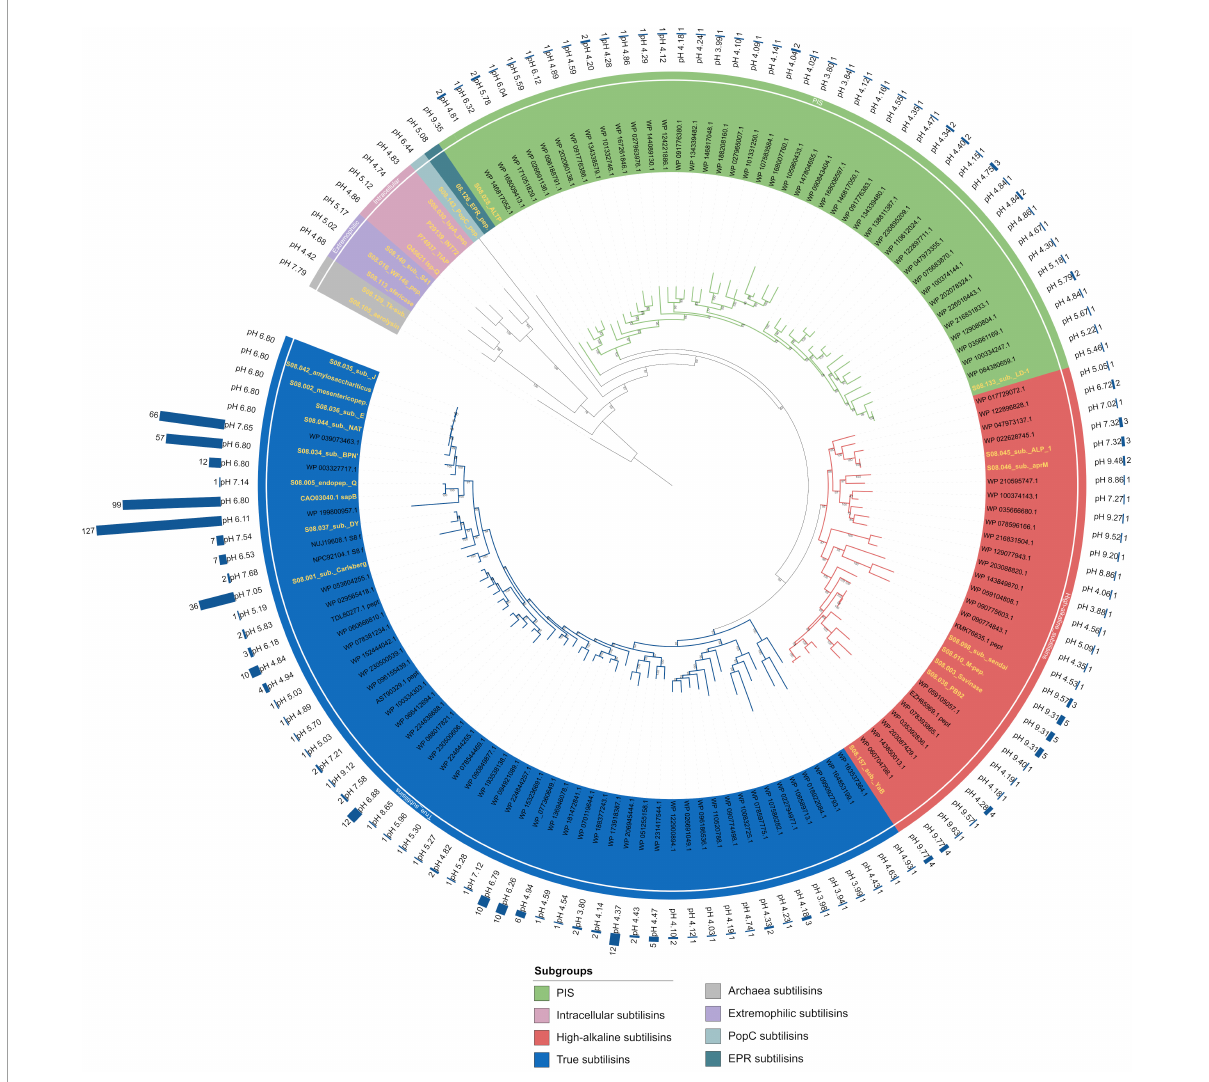
FIGURE3 Phylogenetic tree of 120 novel subtilisins from Bacillaceae identified by a database search. The tree was constructed with IQ-TREE using the maximum likelihood method with ultrafast bootstrap support (model: LG + I + G4 predicted by Modelfinder, 1,000 replicates). The coloured area inside and outside the labels represents the subgroups, as indicated in the legend. The theoretical isoelectric point is given for each sequence in the outer circle. Aerolysin was chosen as the outgroup. Archaea subtilisins, extremophilic subtilisins, EPR – and PopC subgroup were added as additional holotypes. All holotypes are highlighted with a yellow text colour. The bar graphs represent the cluster size of the data mining search. For each group, the numbers above the branches indicate the bootstrap values based on 1000 replications. The tree can be accessed at the following link: